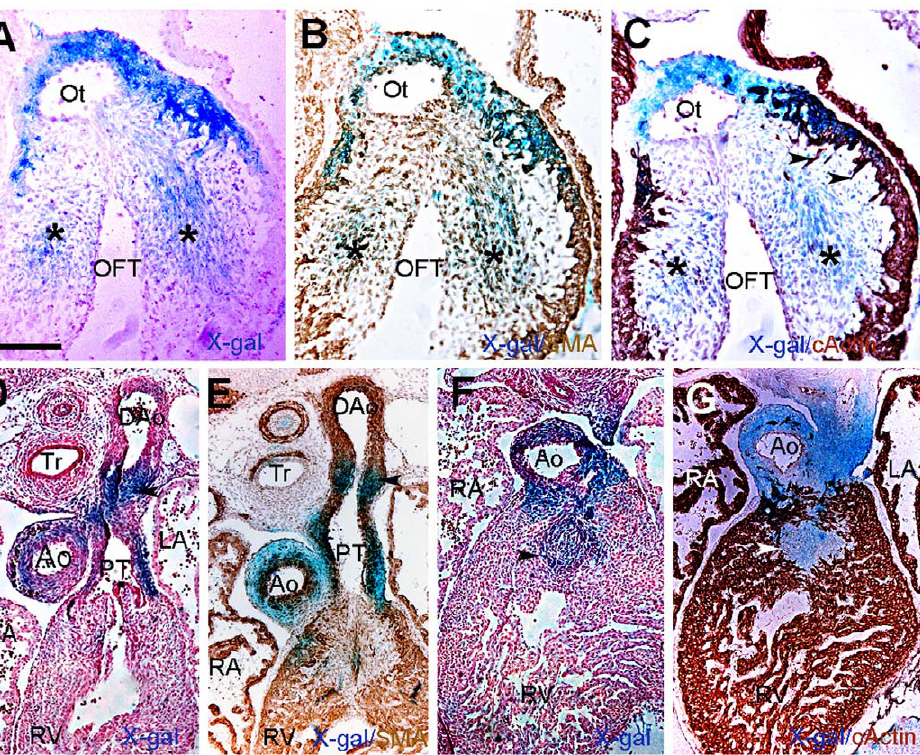
Figure 4. Distribution of X-gal-labeled cells in transgenic hearts before (E11.5) and after (E13.5) outflow tract septation. Transverse sections of E11.5 (A-C), and E13.5 (D-G) developing hearts (A) X-gal-labeled cells are present in the cushion of E11.5 embryos (asterisks) and (B) on adjacent section, a -SMA staining shows that lacZ -expressing cells correspond to cardiac neural crest differentiating into smooth muscle that (C) are negative for c-actin expression and are thus not muscularized. Arrowheads in C indicate myocardial spikes protruding toward the cushion mesenchyme. (D) X-gal stained cells are detected in the aortic and pulmonary trunk as well as in the ductus arteriosus (arrowhead). (E) These lacZ - positive cells also express a -SMA. (F) At E13.5, the outlet septum stains positive for X-gal (arrowhead). (G) c-actin immunostaining demonstrates that myocardialization occurs in this region as well as in the cushion at base of the aorta. Ao, aorta; DAo, dorsal aorta; LA, left atrium; OFT, outflow tract; Ot, outlet; PT, pulmonary trunk; RA, right atrium; RV, right ventricle; Tr, Trachea. Scale bars=100 m